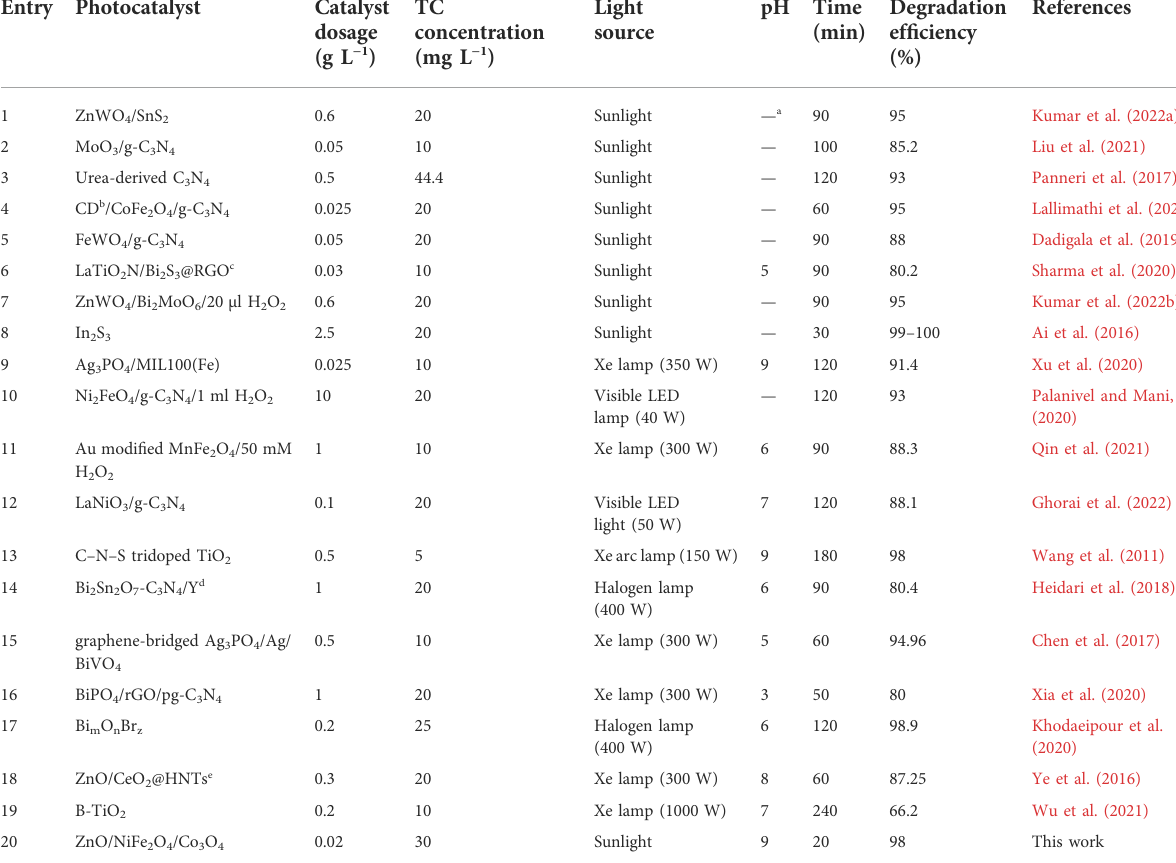
TABLE 2 Comparison of the ef fi ciency of ZnO/NiFe 2 O 4 /Co 3 O 4 vs . all previously studied photocatalysts under natural sunlight and some recently reported procedures under visible light for TC degradation. Entry